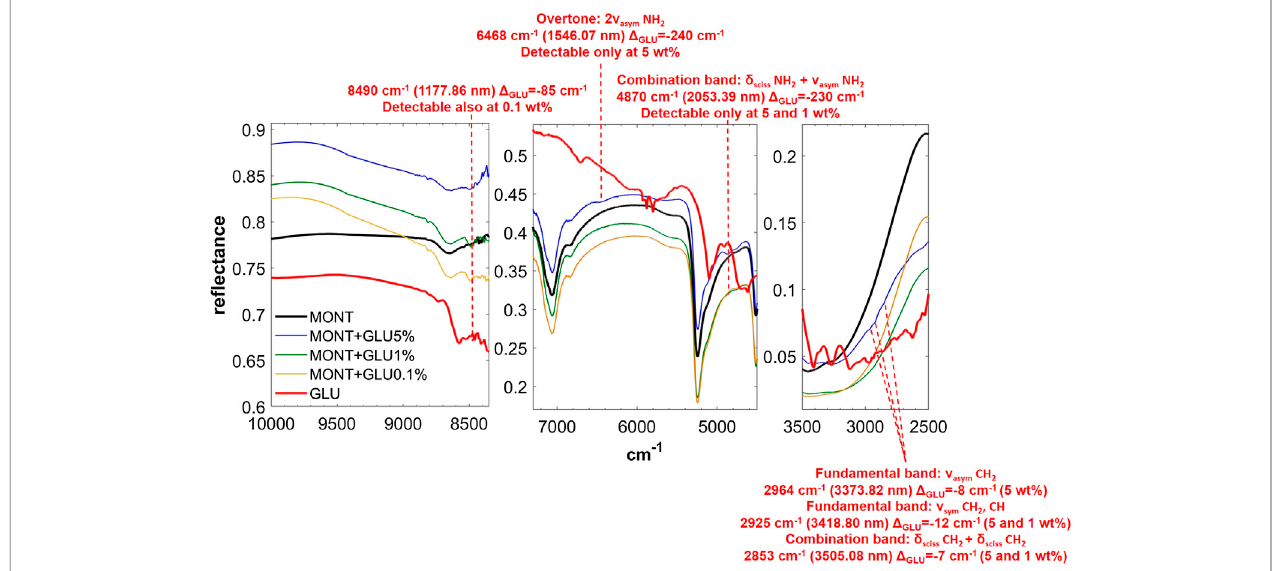
FIGURE4| NIRspectraofGLUadsorbedonmontmorilloniteat5,1,and0.1 wt%concentration.Legend: Δ GLU (cid:2) wavenumbershiftwithrespecttothesamepeak of the pure molecule in the solid state; ν (cid:2) stretching vibrational mode; δ (cid:2) bending vibrational mode; sciss (cid:2) scissoring in-plane vibrational mode; sym (cid:2) symmetric vibrational mode; asym (cid:2) asymmetric vibrational